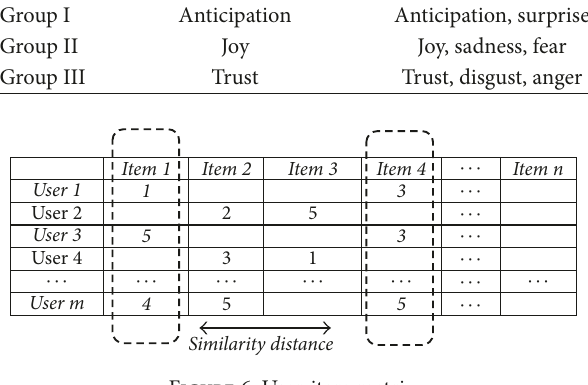
Table 5: Emotion groups in the recommendation process.